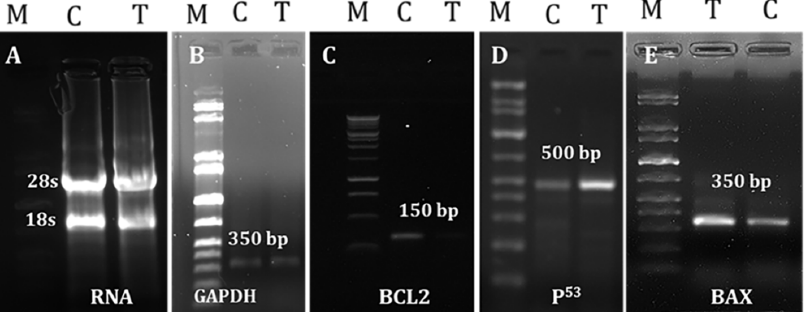
Figure 4. Study of the mRNA ‐ expression pattern of apoptotic ‐ related genes through RT ‐ PCR. C, T, and M refer to EAC ‐ cell ‐ bearing control mice (untreated), LGBME ‐ treated mice, and molecular marker, respectively. The band length is indicated as bp. ( A ) Isolated RNA from both control and treated EAC cells in 1% agarose ‐ gel electrophoresis; ( B ) expression of housekeeping gene, GAPDH; ( C ) expression of the anti ‐ apoptotic gene, Bcl ‐ 2; ( D , E ) expression of the pro ‐ apoptotic genes, p53 and Bax.